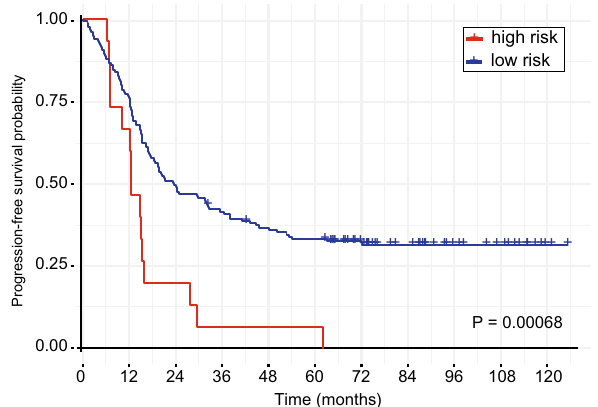
Figure 3. Progression-free survival for patients with overexpressed mRNA candidates. Survival curve shows that “high risk” (all overexpressed candidates) group have an overall shorter time to recurrence outcome compared to “low risk” (at least one candidate downregulated) in OC patients. P value is presented above.